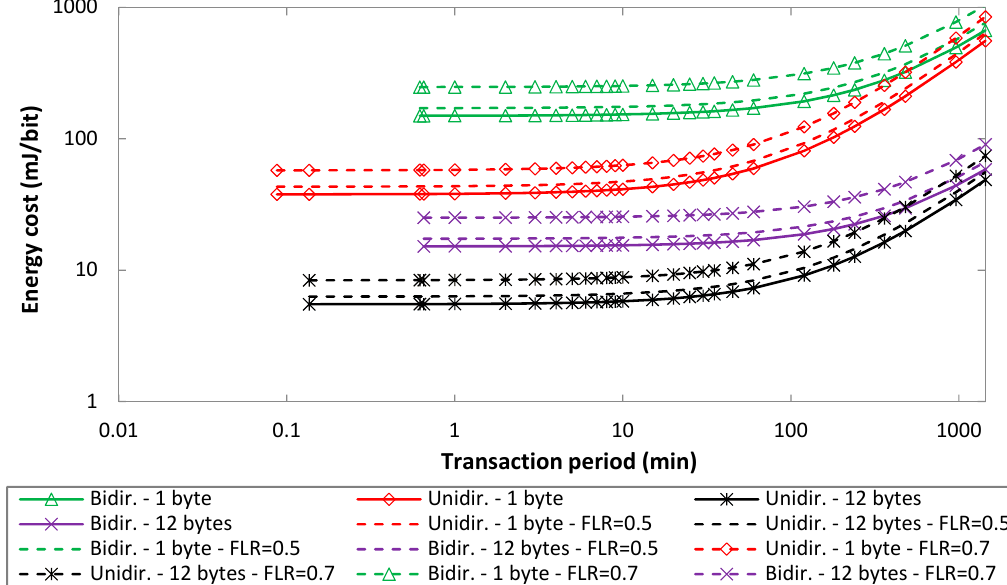
Figure 11. Energy cost of data delivery, for unidirectional and bidirectional transactions, as a function of T Period , for uplink payload sizes of 1 byte and 12 bytes, for an uplink bit rate of 100 bit/s, and for different FLR values.